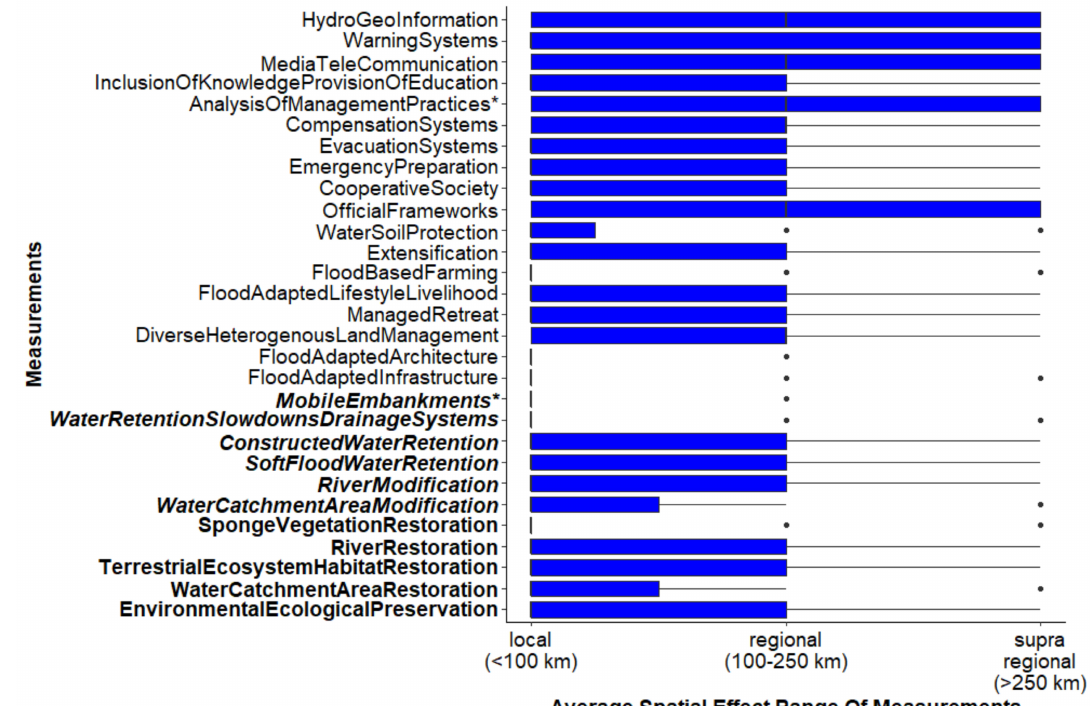
Figure 8. Average effective spatial range of FMM (N = 29). Multiple choice was possible. * Only represented in SDS-2. Instrumental measures (plain), structural measures ( bolditalic ), and natural measures ( bold